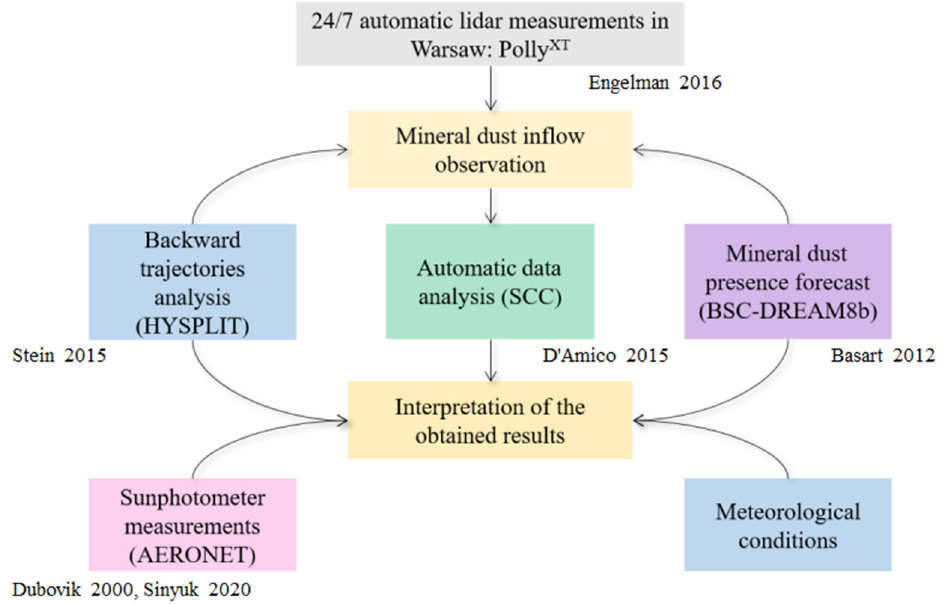
Figure 1. A diagram of the research methodology constituting a logical sequence of thought with marked references to the algorithms and models used [29,30,32,33,36,37].